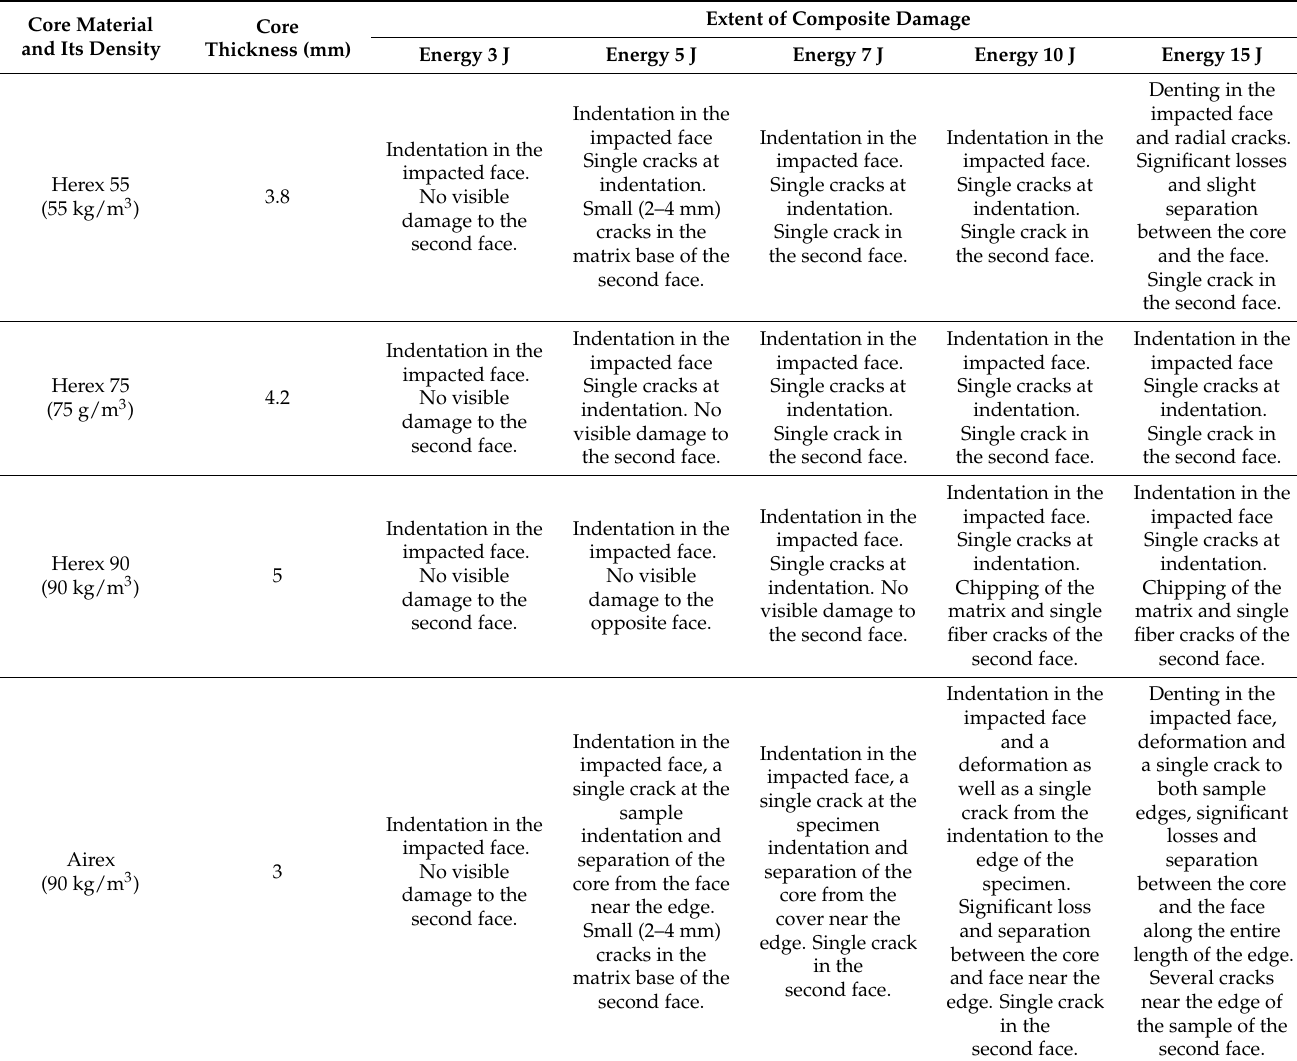
Table 3. Description of damage of sandwich composites.